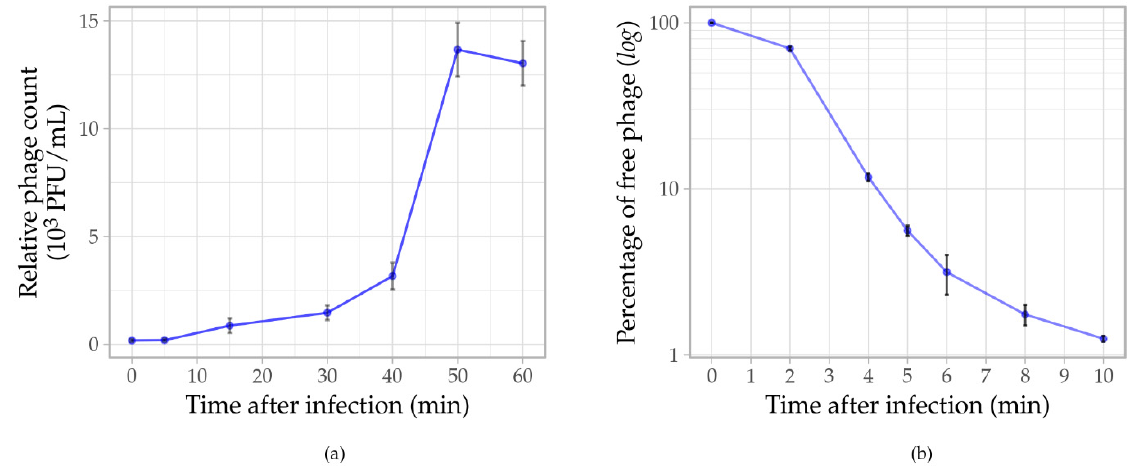
Figure 4. ( a ) One step growth curve depicting the infection of S. maltophilia AP143S by phage Ps15 at a MOI of 0.001. ( b ) Phage adsorption assay. Error bars indicate the standard deviation of triplicates.